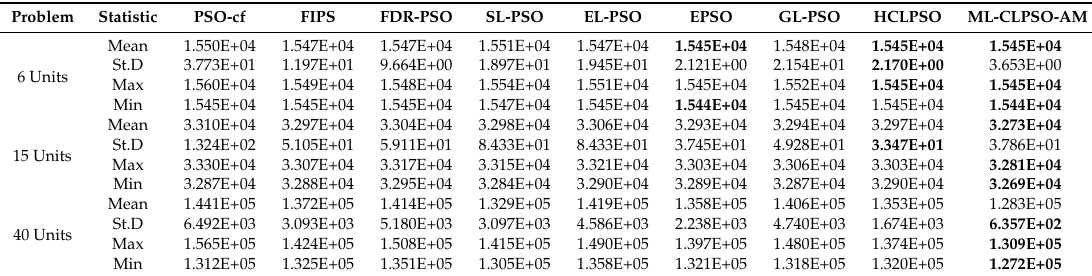
Table 6. Comparison test results of PSO algorithms on ELD problems.